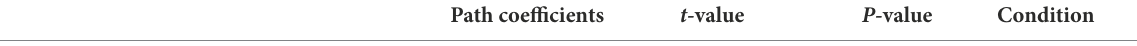
TABLE 7 Investigates the relationship between social networks and self-handicapping with the mediating role of academic achievement. Path coefficients Social networks → Academic Achievement →